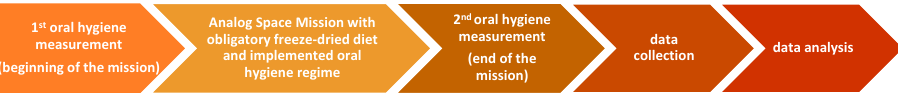
Figure 4. Methodology of the conducted research—single mission .